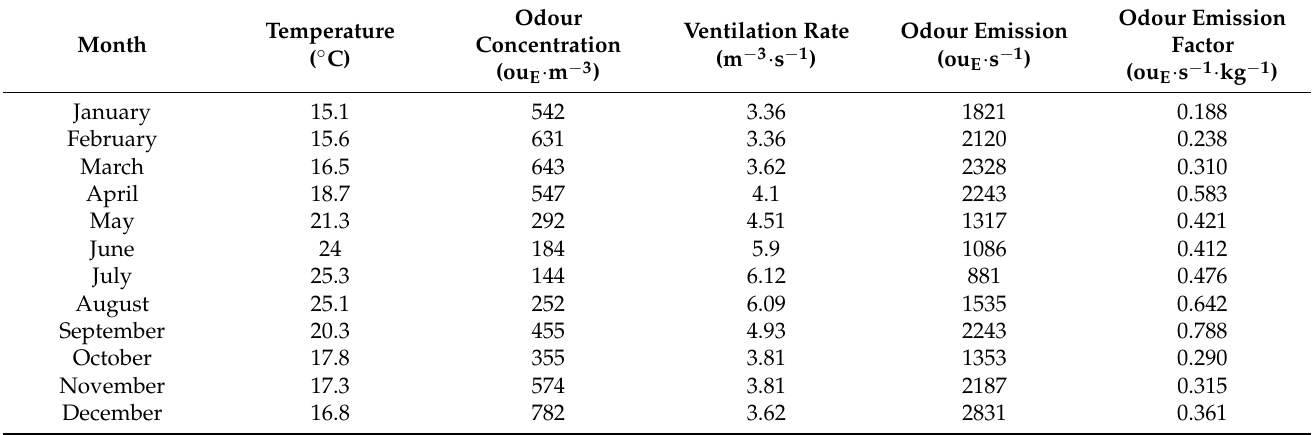
Table 3. Mean odour concentration and odour emission factors for fattening pigs Adapted from [23] own